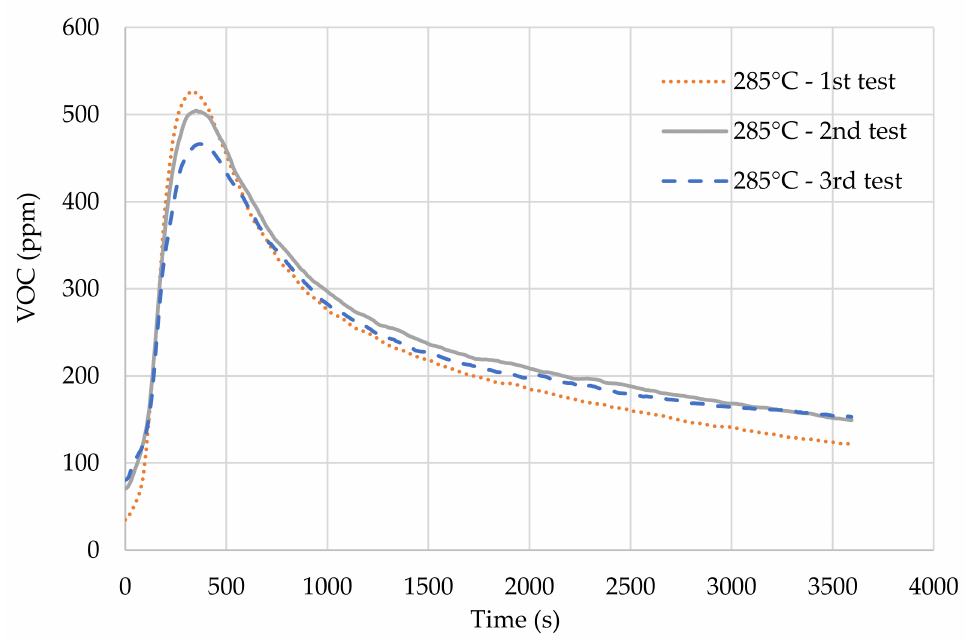
Figure 17. Time course of VOC total emission at 285 ◦ C.